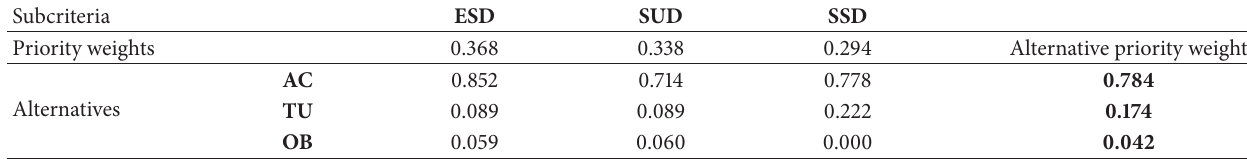
Table 7: Summary combination of priority weights: subcriteria of flexibility.